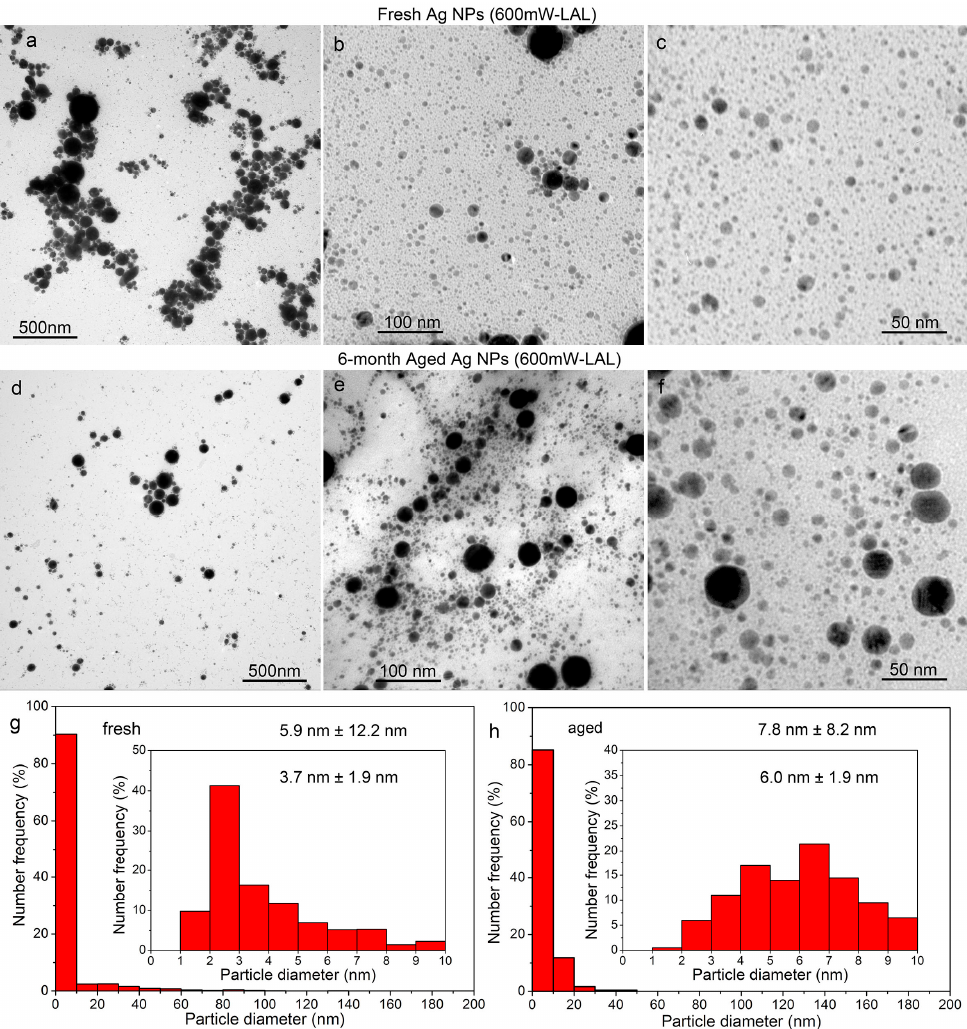
Figure 3. TEM images ( a – f ) and sizes distributions ( g , h ) of fresh ( a – c , g ) and six month ( d – f , h ) aged Ag particles, synthesized by laser ablation of Ag in acetone at laser power of 600 mW.